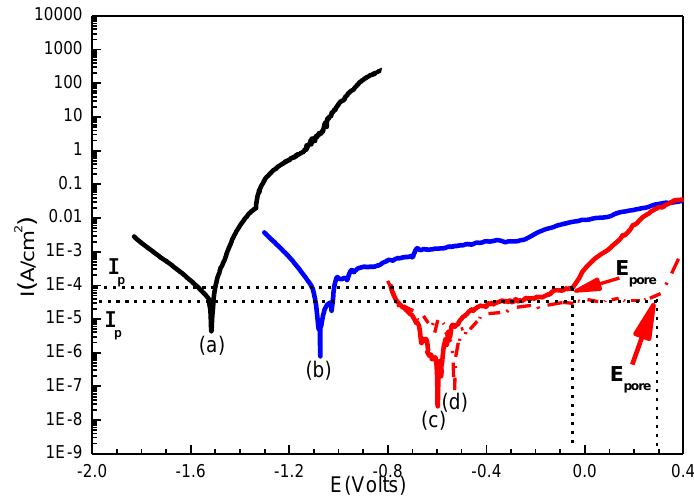
Figure 5. Polarization curves of ( a ) the bare Mg alloy substrate, ( b ) the NiPC, ( c ) unannealed and ( d ) annealed NPC/Phosphate, in a 3.5 wt % NaCl aqueous solution. Table 2. Results of potentiodynamic polarization curves of AZ31B substrate, different Ni-P coating in 3.5 wt % NaCl solution.